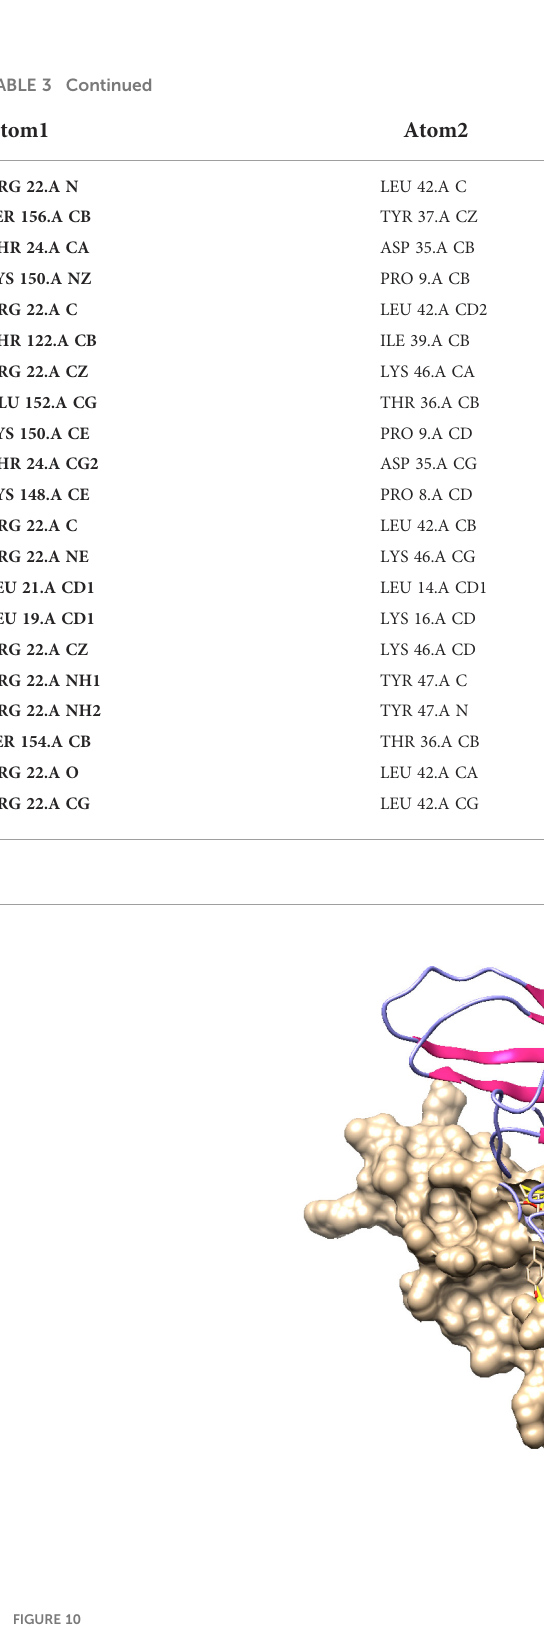
FIGURE 10 Docked Fas/FasL complex. In this fi gure, molecular docking has been shown. Docking is the Bioinformatics assessment of how two proteins (Fas and FasL) fi t best as a complex. Fas and FasL are shown with distinct colors (purple and beige). Fas/FasL complex contacts are highlighted with yellow